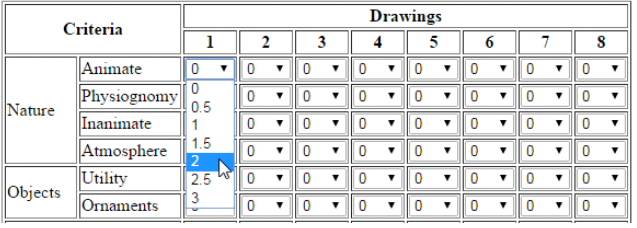
Fig. 1. FWAT score input